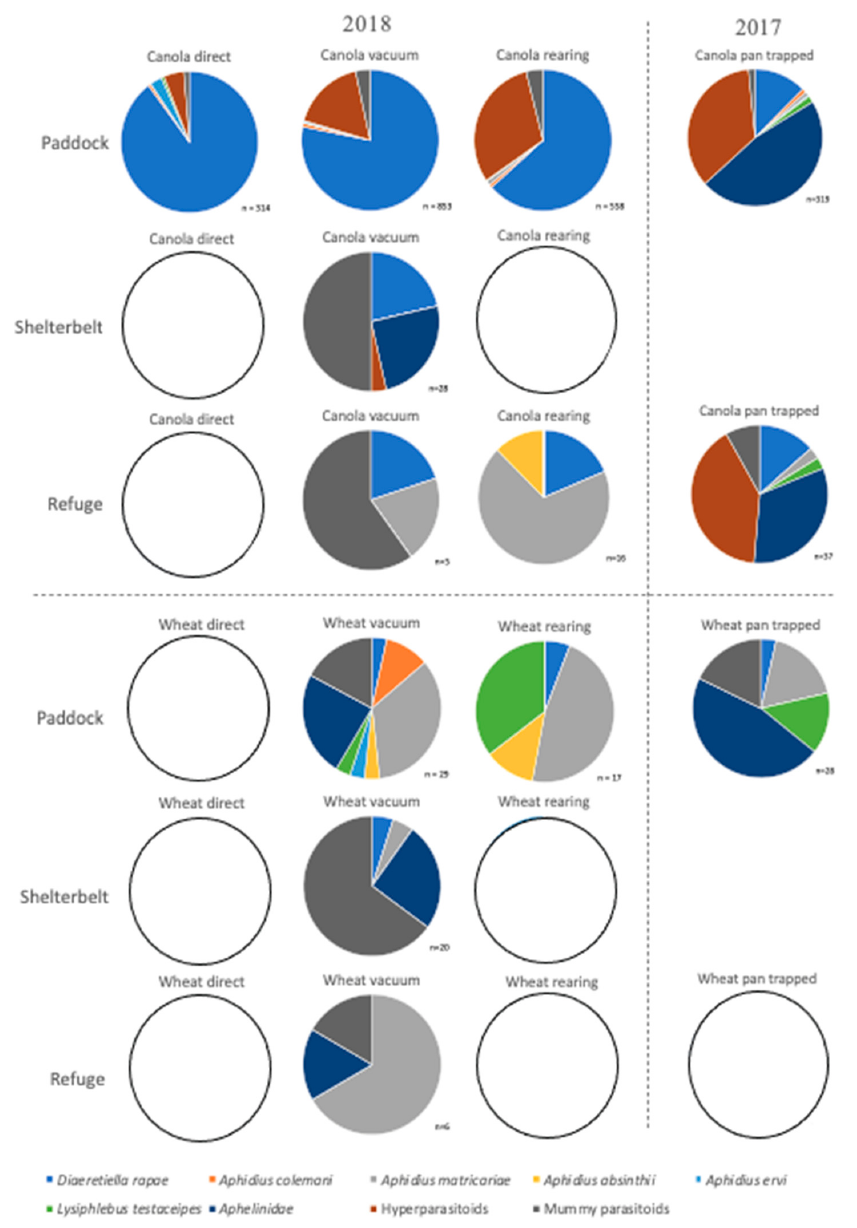
Figure 9. Parasitoid species sampled within fields and their neighbouring vegetation, sampled directly for two minutes, by vacuum for one minute, through rearing of mummies from directly sampled mummies over two minutes, or from pan trapping over 24 h, in 2017 and 2018. Where n < 5, pie charts are shown as empty circles.